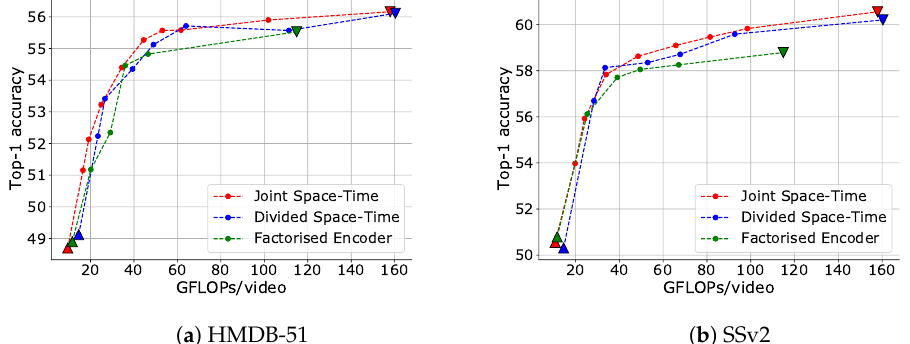
Figure 6. Trade-off between top-1 accuracy and inference cost adjusted via IPS for each attention type of TimeSformer. An input clip has 24 frames with a frame size of 144 × 144 and 6 fps. The data point with the highest FLOPs for each setting is when no input reduction is performed (upper bound), and the data point with the lowest FLOPs is when only I-frames are input (lower bound). The upper and lower bounds are plotted as inverse triangles and triangles, respectively.